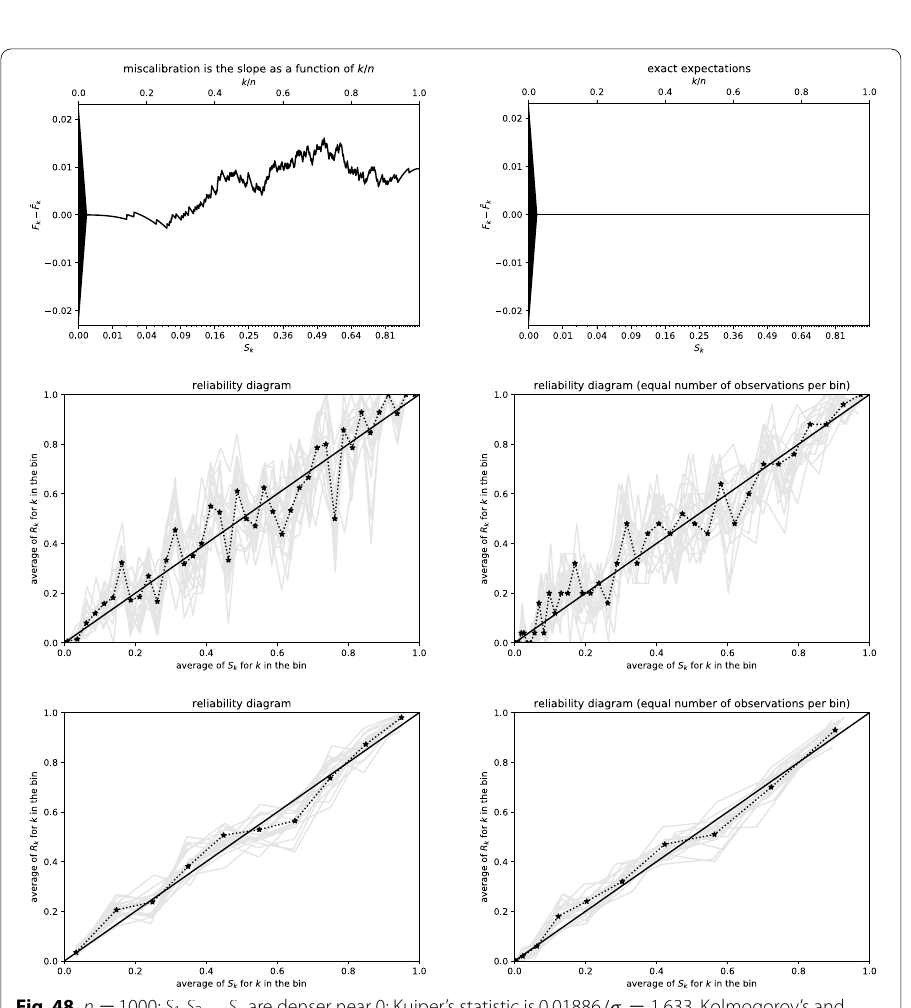
Fig. 48 n = 1000; S 1 , S 2 , ..., S n are denser near 0; Kuiper’s statistic is 0.01886 /σ = 1.633 , Kolmogorov’s and Smirnov’s is 0.01606 /σ = 1.391 . Figure 49 displays the ground-truth reliability